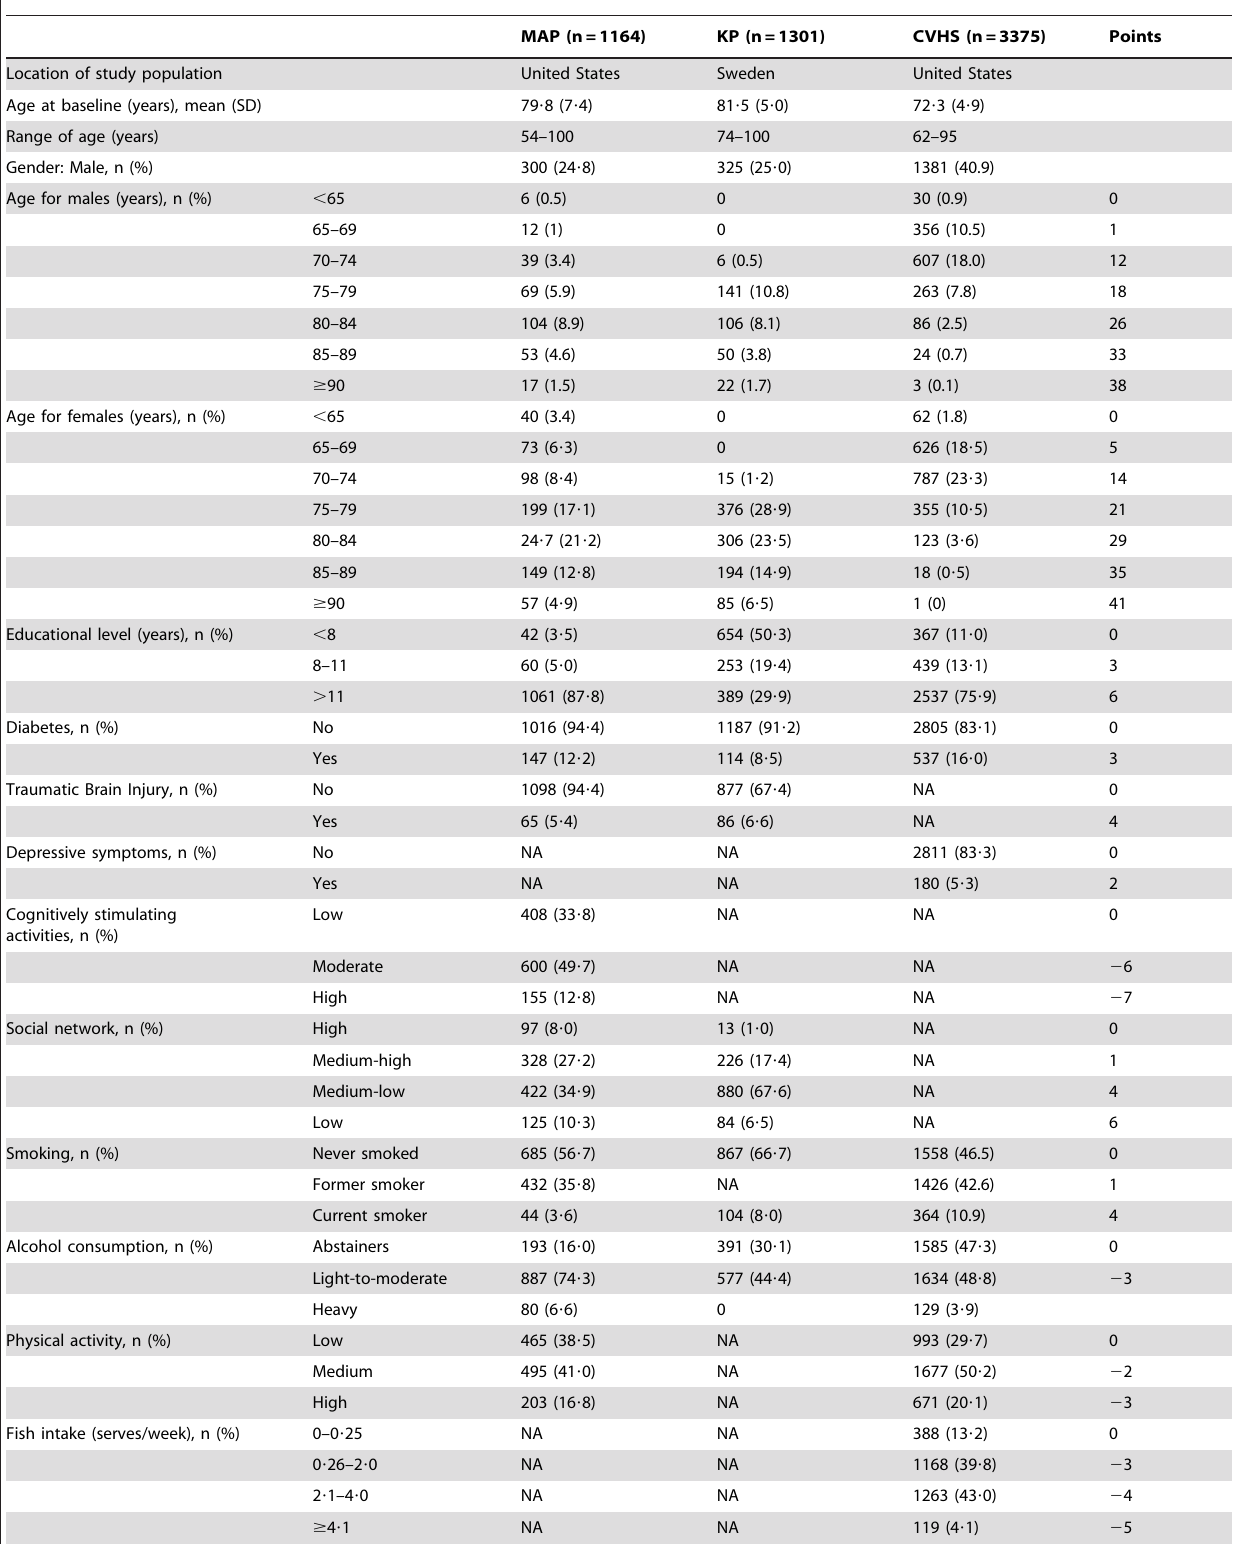
Table 2. Descriptive statistics for the three evaluation cohorts, their measured risk and protective factors, and the points allocated to each factor on the